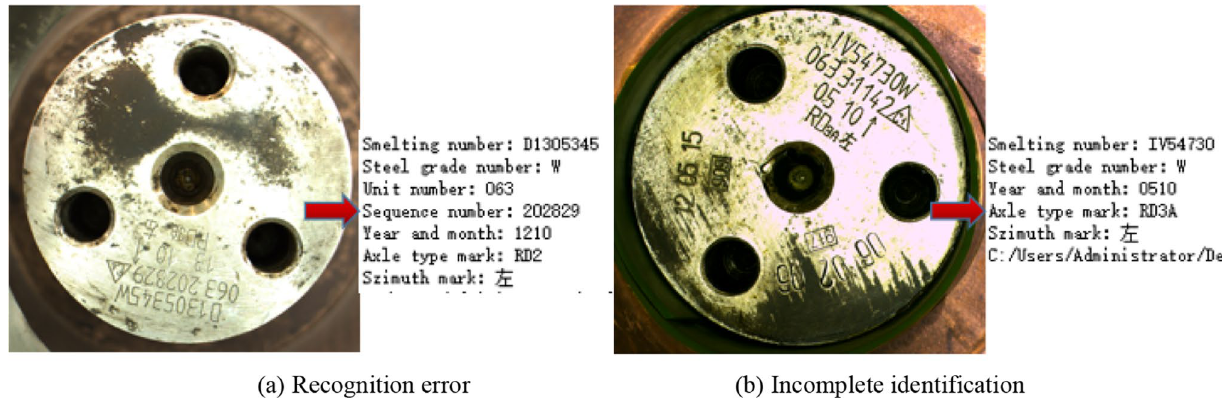
Fig. 8 Problems after the enhancement of the traditional Laplacian